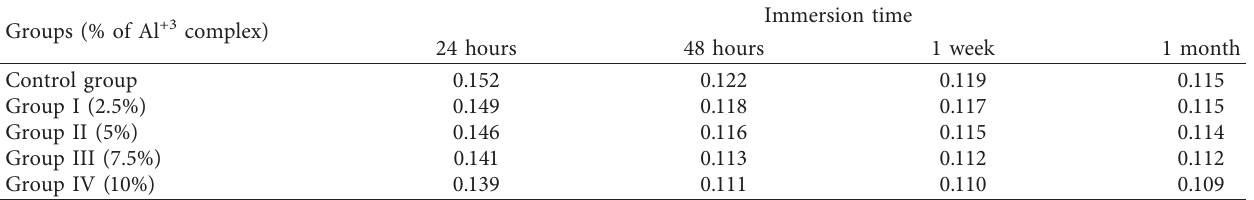
Table 5: Fluoride ion release ( μ g/mm 2 ) from C-GIC and Al-GICs after immersion in deionized water for different times. Groups (% of Al +3